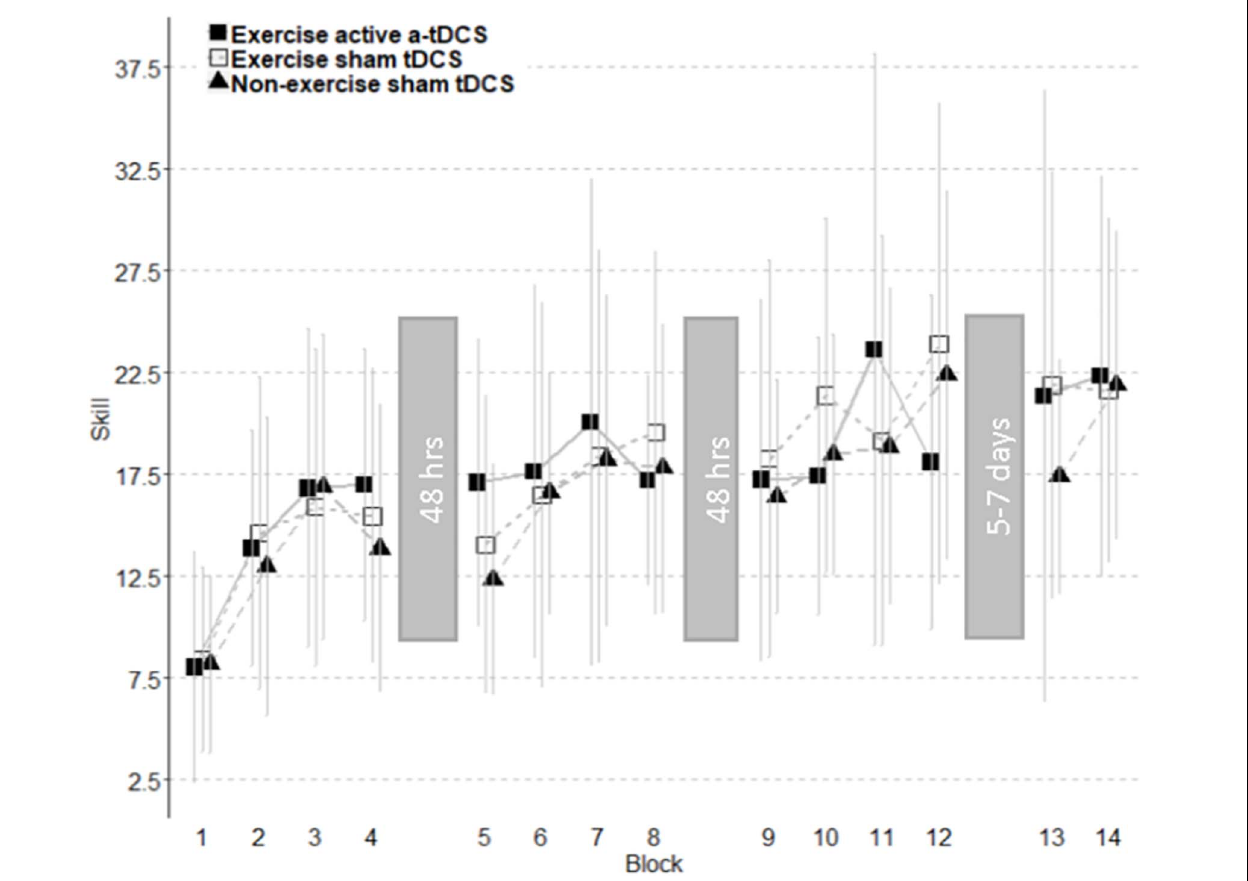
FIGURE 4 | Improvement of motor-skill across all blocks. Skill change curves are separated into individual sessions with the time between sessions displayed within grayed blocks. The analysis of subcomponents showed an increase in motor skill over three intervention sessions observed across all groups. A trend toward a decrement of skill was observed between the first and second intervention session. Retention did not differ between groups. Error bars represent standard